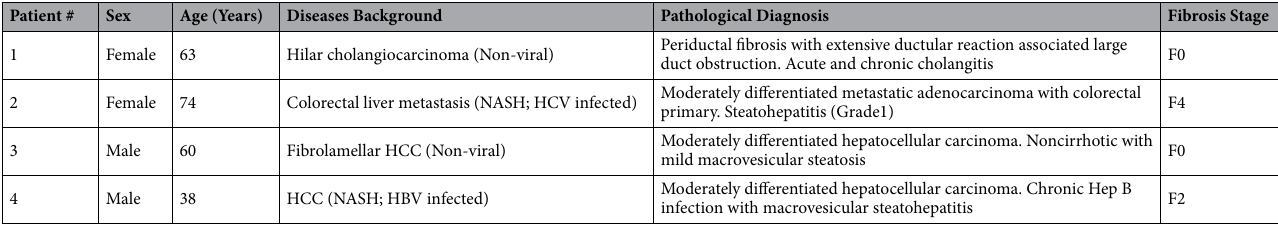
Table 1. Characteristics of human liver donors for PCLS